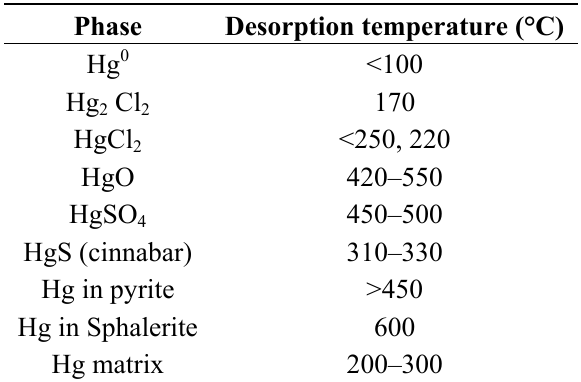
Table 5. Desorption temperatures of different mercury minerals.